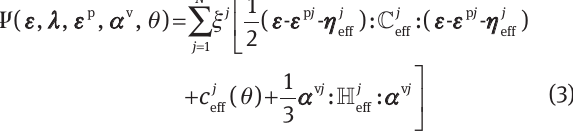
Figure 1: Material point level with differently oriented grains (left) and exemplary volume fractions of the different phases (right).